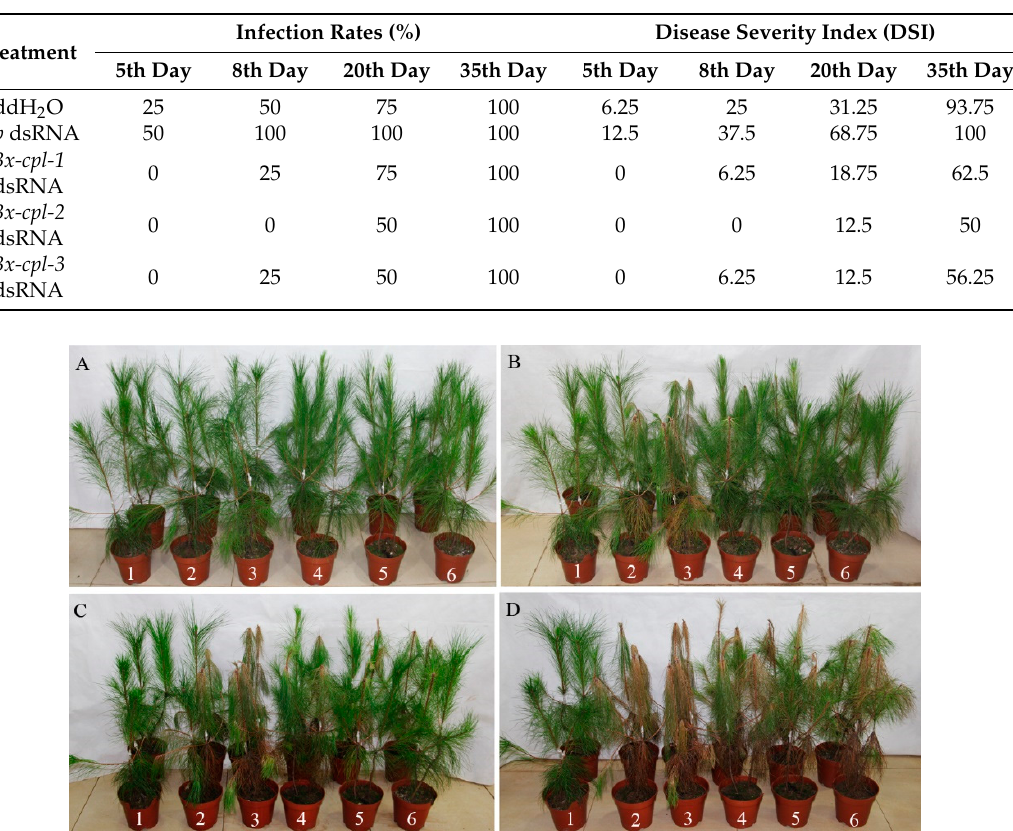
Figure 8. Symptoms in P. massoniana after inoculation with nematodes. Symptoms 0 days after inoculation ( A ); Symptoms 8 days after inoculation ( B ); Symptoms 20 days after inoculation ( C ); Symptoms 35 days after inoculation ( D ). Pines inoculated with ddH 2 O (1); B. xylophilus soaked in ddH 2 O (2); B. xylophilus gfp dsRNA (3); B. xylophilus Bx-cpl-1 dsRNA (4); B. xylophilus Bx-cpl-2 dsRNA (5); B. xylophilus Bx-cpl-3 dsRNA (6).